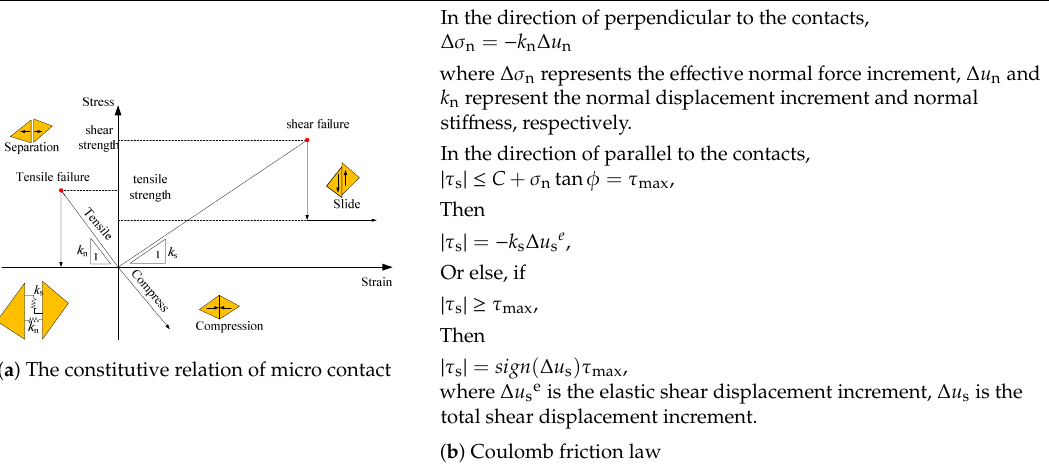
Table 4. Mechanical properties of intact rock and calculated rock